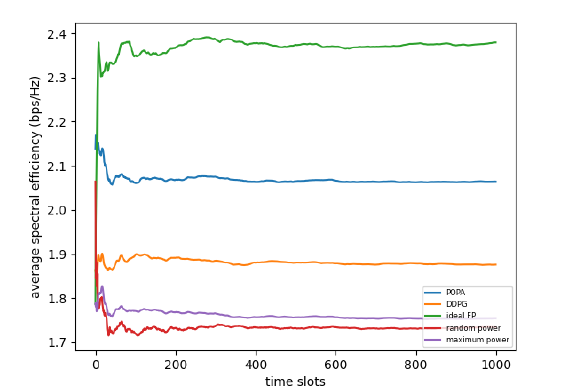
Figure 6. Average spectral efficiency (bps/Hz) in 1000 time slots.